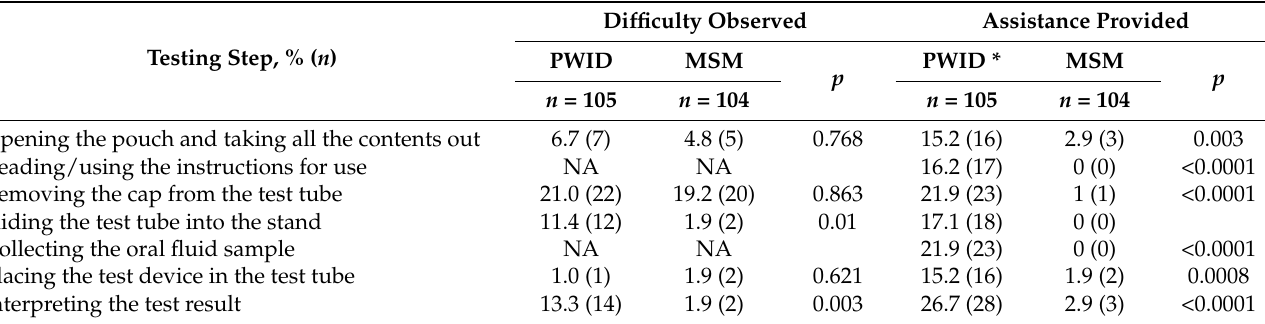
Table 3. Observer assessment of difficulties and steps requiring